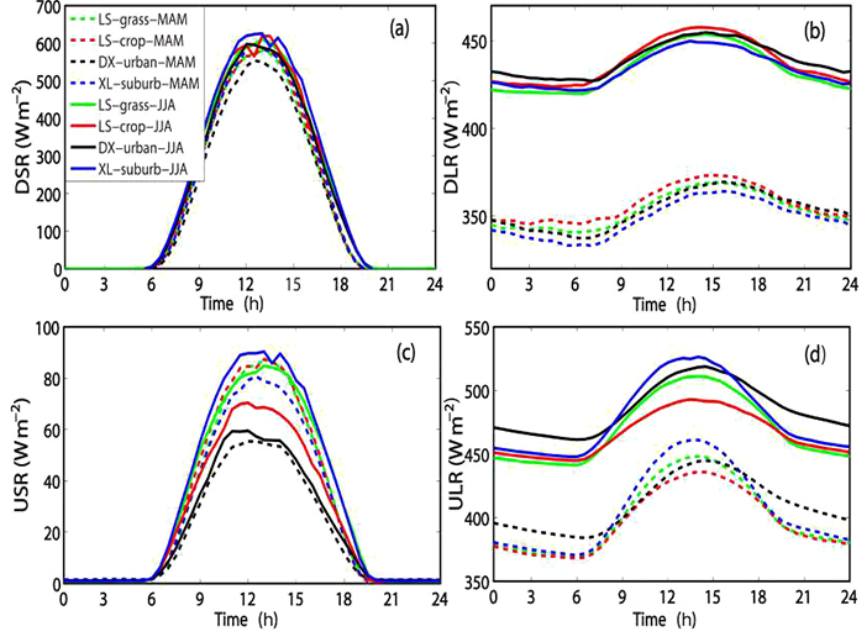
Figure 6. Diurnal variation in (a) downward shortwave radiation (DSR), (b) downward longwave radiation (DLR), (c) upward shortwave radiation (USR), and (d) upward longwave radiation (ULR) at the four sites in Nanjing.